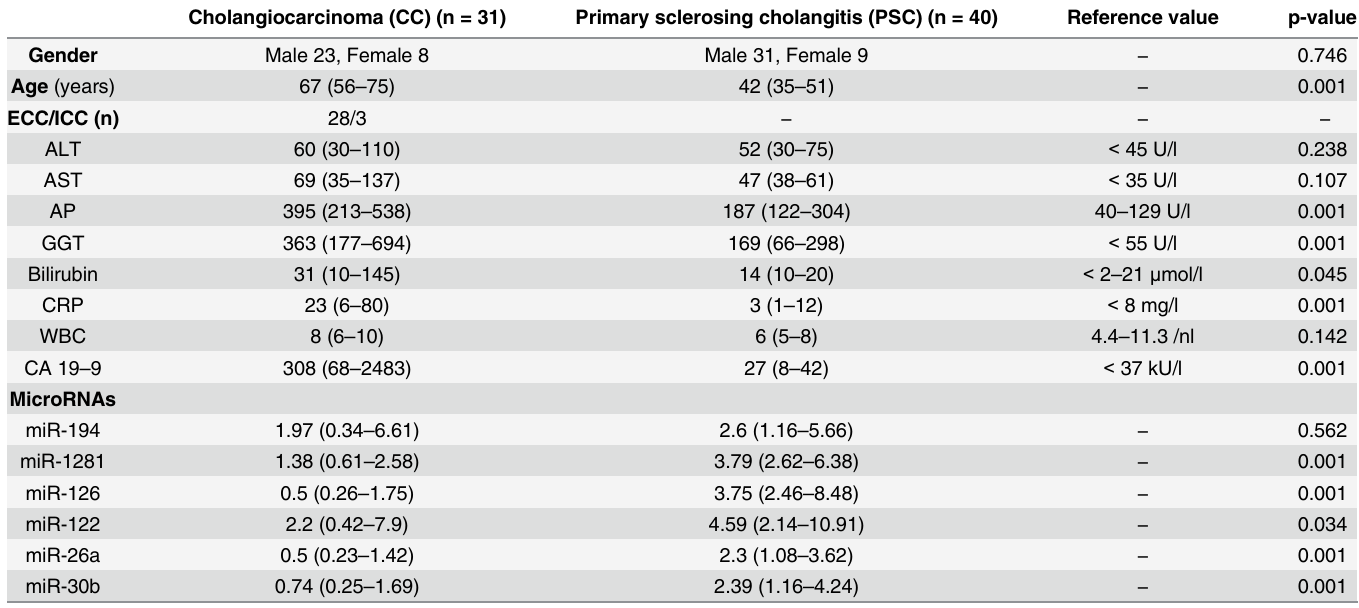
Table 2. Clinical features, demographics and laboratory values of the patient cohorts. The aforementioned parameters are presented in Table 2 (Serum). Patients with primary sclerosing cholangitis (PSC) and cholangiocarcinoma (CC) were compared regarding demographics, laboratory and micro- RNA (miRNA) values. Data were expressed as number or median with interquartile range (IQR). ECC: extrahepatic cholangiocarcinoma; ICC: intrahepatic cholangiocarcinoma; ALT: alanine aminotransferase; AST: aspartate aminotransferase; AP: alkaline phosphatase; GGT: gamma-glutamyl transferase; CRP: C-reactive protein; WBC: white blood cells; CA 19 – 9: carbohydrate antigen 19 – 9. Cholangiocarcinoma (CC) (n =